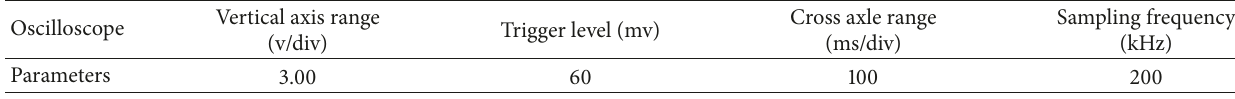
Table 1: Experimental setting parameters of